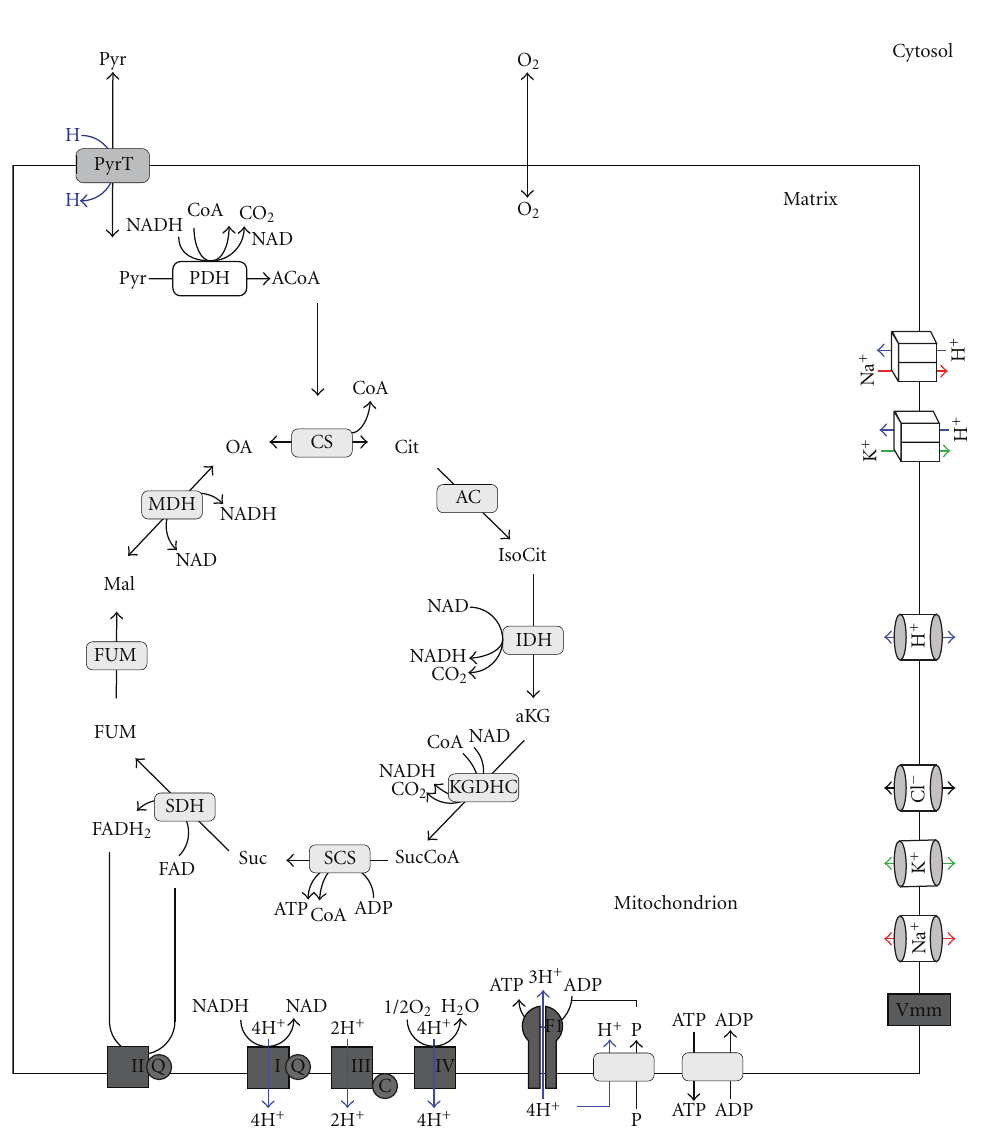
Figure 1: Schematic of the mathematical model. Pyruvate (Pyr) is the only substrate of the TCA cycle. Pyruvate is decarboxylated by pyruvate dehydrogenase (PDH) to acetyl-CoA (ACoA), which is then condensed with oxaloacetate (OA) to citrate (Cit) via the citrate synthase (CS). Citrate is converted to isocitrate (IsoCit) by the aconitase (AC), which is further converted to α -ketoglutarate (aKG) via the isocitrate dehydrogenase (IDH) producing NADH from NAD in the process. The α -ketogluterate dehydrogenase complex (KGDHC) catalyses the reaction of α -ketogluterate with Coenzyme A to succinyl-CoA (SucCoA) under reduction of NAD to NADH. Succinyl-CoA is further metabolized by succinyl-CoA synthase (SCS) to succinate (Suc) by phosphorylating ADP to ATP (substrate-chain phosphorylation). Succinate is dehydrogenated to fumarate (Fum) by the succinate dehydrogenase (SDH, complex II) reducing ubiquinone to ubiquinol (see legend of Figure 2). Fumerase (FUM) converts fumerate to malate (Mal), which is oxidized by malate dehydrogenase (MDH) again producing one NADH and regenerating the initial oxalacetate so the cycle can start over again. In summary, PDH and the TCA cycle produce one ATP from ADP, one ubiquinol from ubiquinone, and four NADHs from NAD while oxidizing one pyruvate to three CO 2 . Oxidation of NADH and/or succinate in the respiratory chain, is coupled to transmembrane proton pumping which generates a proton gradient and a mitochondrial membrane potential. The proton gradient is used to fuel pyruvate uptake from the cytosol into the matrix via pyruvate transporter, pumping of sodium, potassium from the matrix into the intermembrane space/cytosol, phosphate transport from the cytosol into the matrix space, and ATP generation by the F0F1-ATPase. The mitochondrial membrane potential drives the ATP/ADP exchange between the matrix and the intermembrane space/cytosol. The model also comprises the passive exchange of protons, sodium, potassium and chloride between the matrix and the intermembrane space/cytosol driven by electrodi ff usion as well as the mitochondrial membrane potential. Cytosolic ATP is hydrolyzed to ADP and phosphate to meet the energy demand of the